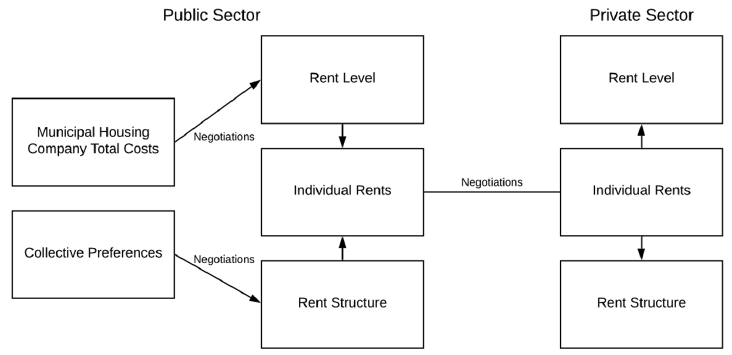
Figure 1: The Swedish use-value